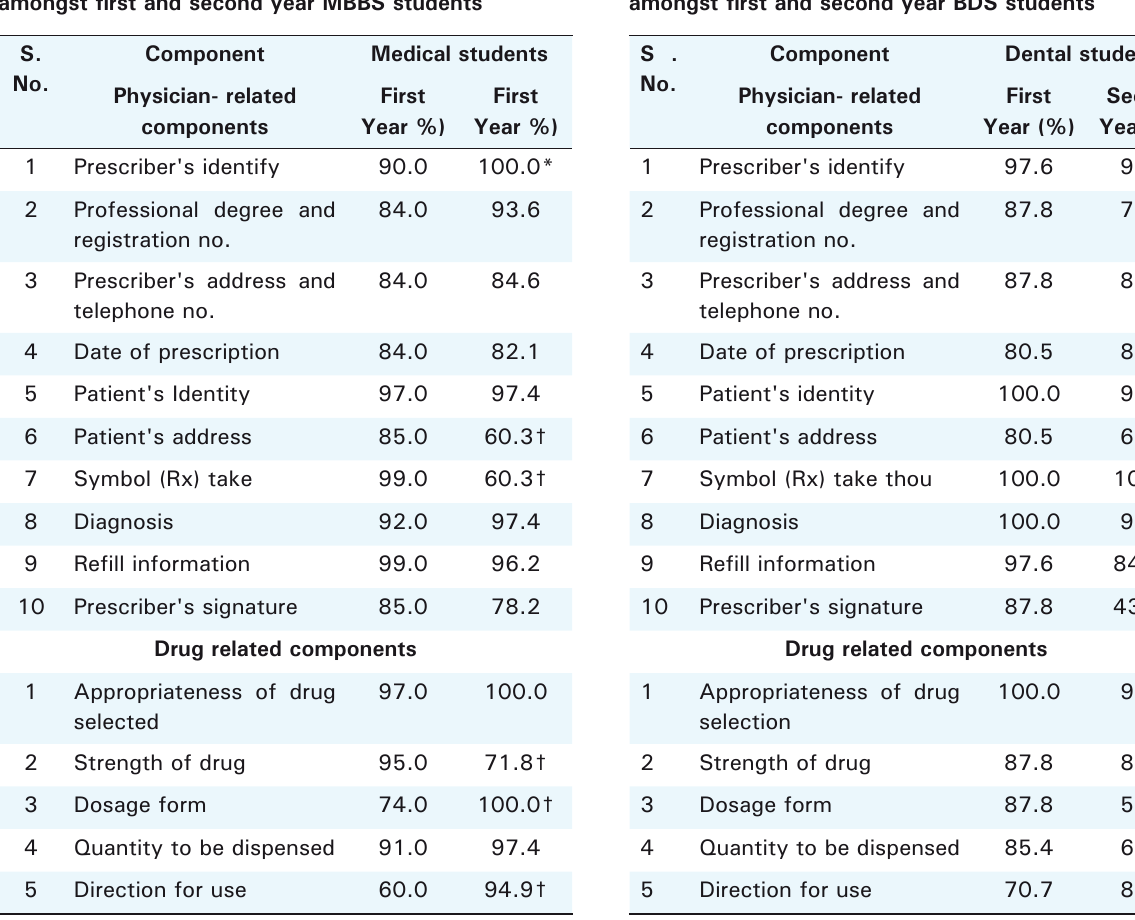
table 2. Performance in prescription writing